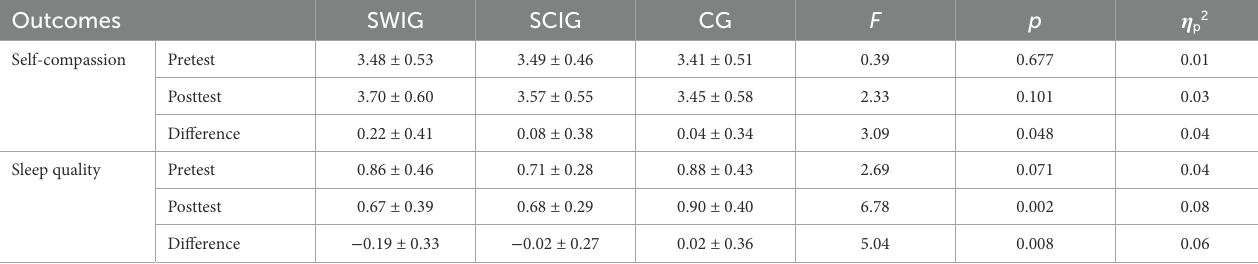
TABLE 2 The difference in self-compassion and sleep quality between pretest and posttest ( M ± SD ).